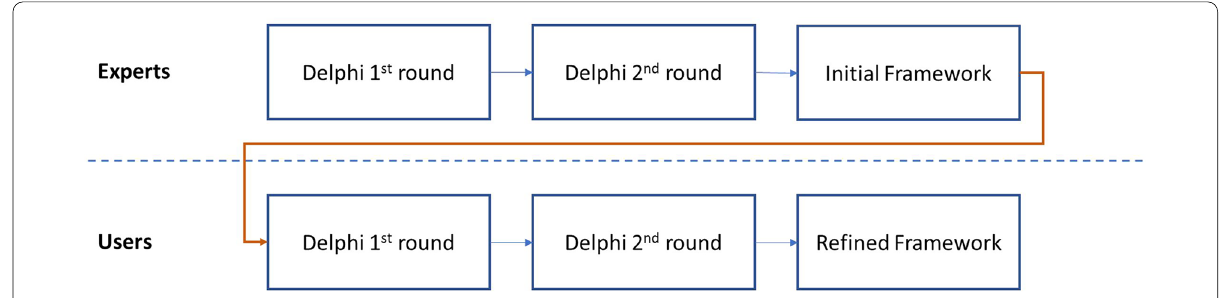
Fig. 1 Structure of the expert/user Delphi